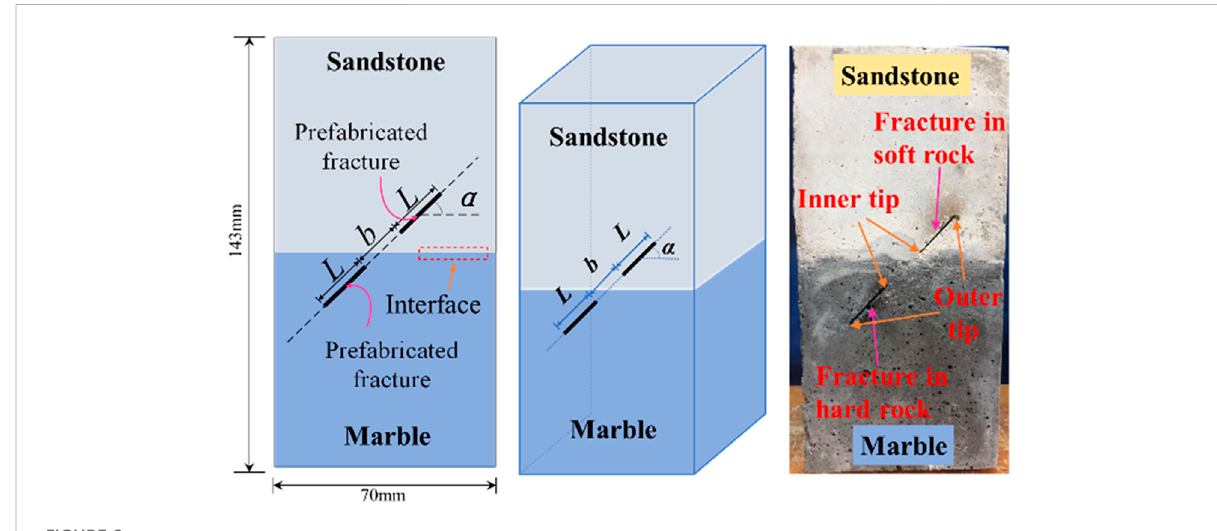
FIGURE 2 Con fi guration of fracture distribution.